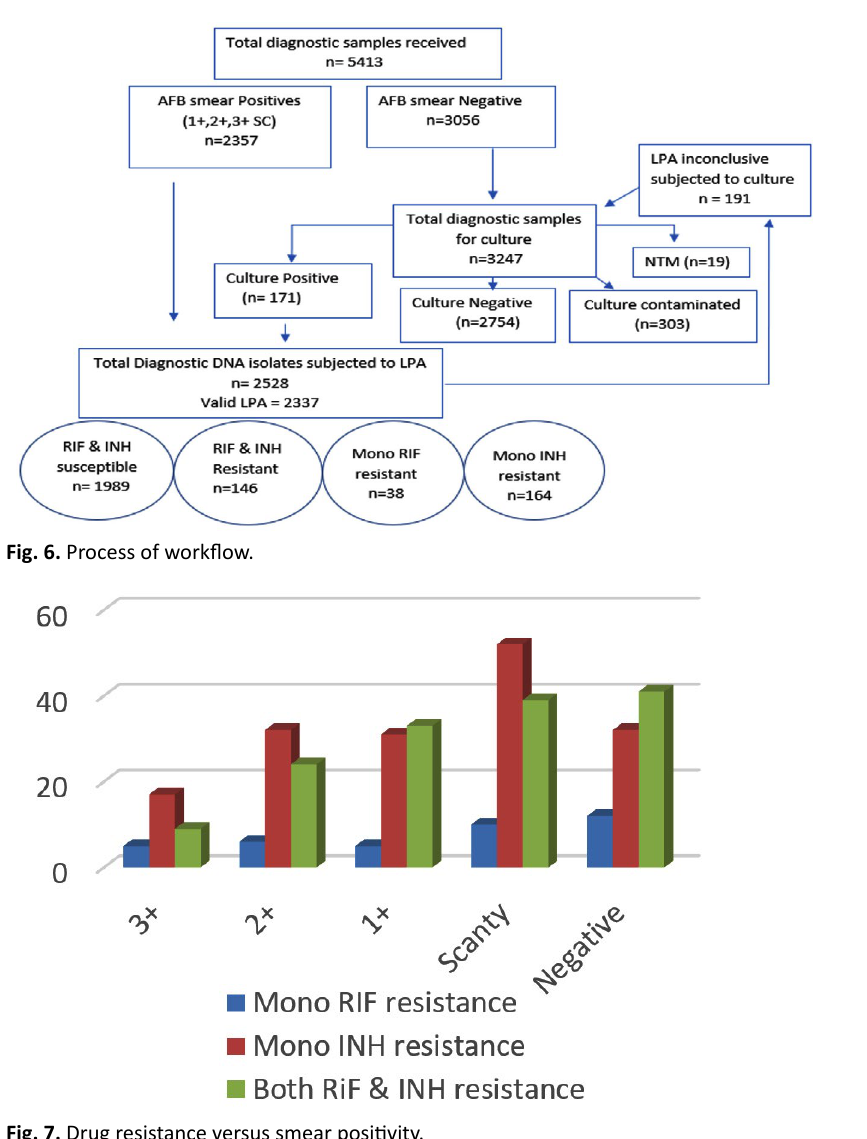
Fig. 7. Drug resistance versus smear